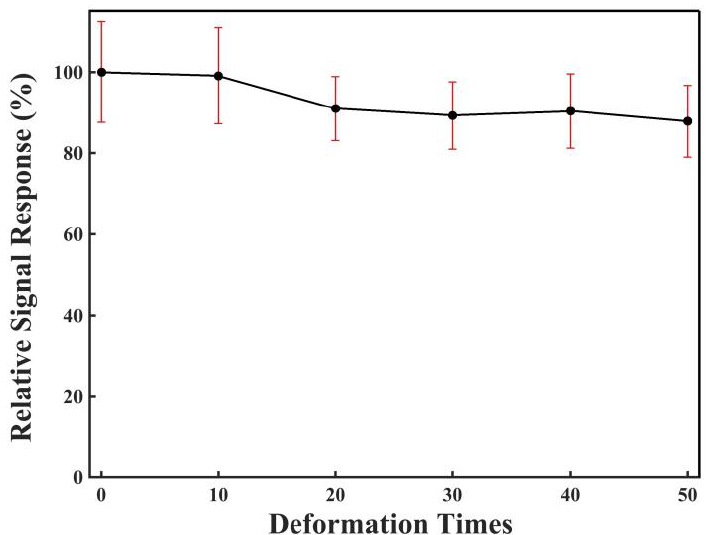
Figure 9. Deformation of the glove sensor based on a three-electrode sensing system for the detection of lactate. The deformation condition: folding back (180 ◦ ) and elongation by 10%. Vertical ordinates: The relative signal response was obtained by normalizing the sensing responses after a certain number of times of deformation to the sensing response before deformation. Lactate concentration: 0.5 mM. Three sensors were used for the measurement.